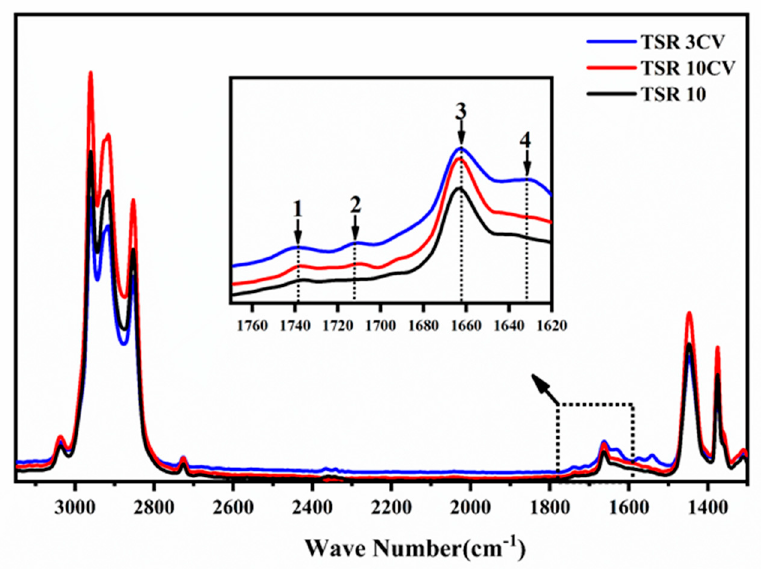
Figure 1. The FT-IR spectra of TSR 10, TSR 10 C, TSR 3CV. Table 2. The different contents of nonisoprene components in TSR 10, TSR 10CV, TSR 3CV. Sample